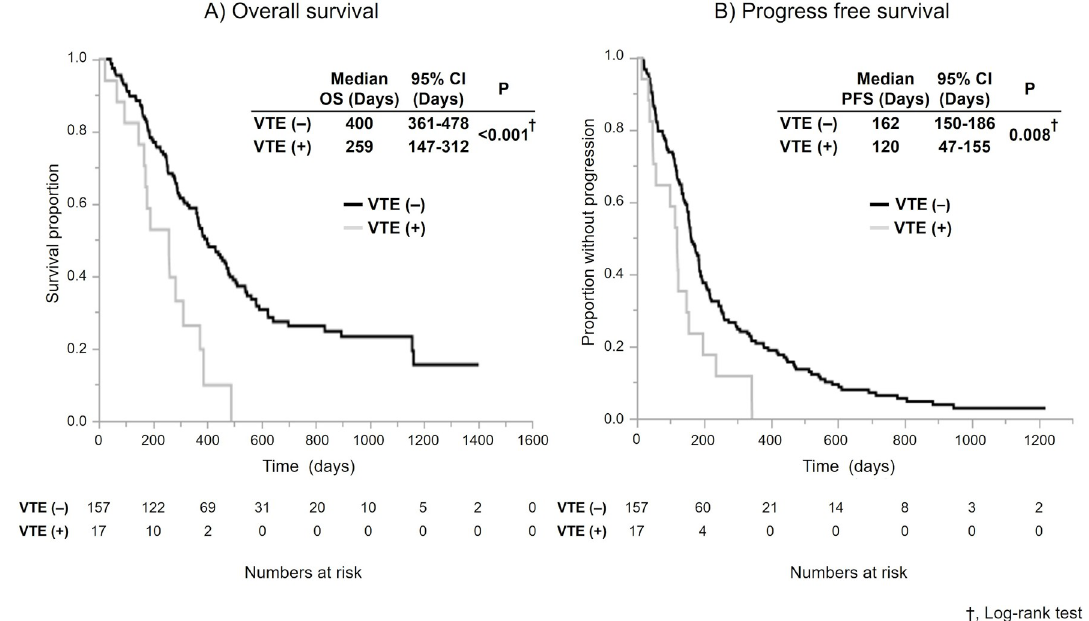
Fig 1. Kaplan–Meier survival curves for (A) OS and (B) PFS. P values were calculated using the log-rank test. OS, overall survival; PFS, progression-free survival; VTE, venous thromboembolism; CI, confidence interval.